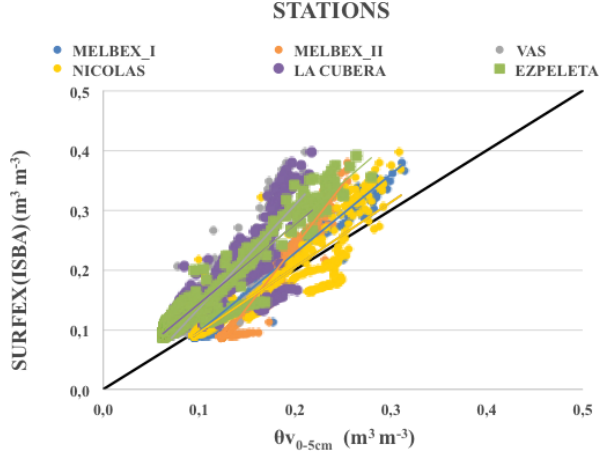
Figure 9. Scatter plot of temporal mean (over the whole simulation period) SSM ground measurements versus SURFEX (ISBA) simu- lations (realistic initial scenario; REAL-I) at all stations. Statistics for all stations using the REAL-I initial scenario are presented in Table